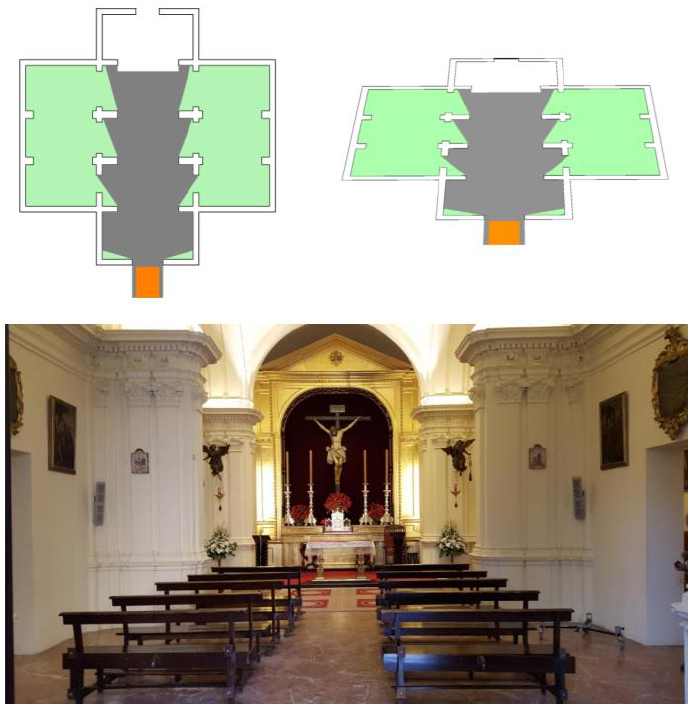
Figure 3. Isovists in 2D and 3D and real image of the chapel from that area. The material produced incorporates AR and VR objects (Figure 4).